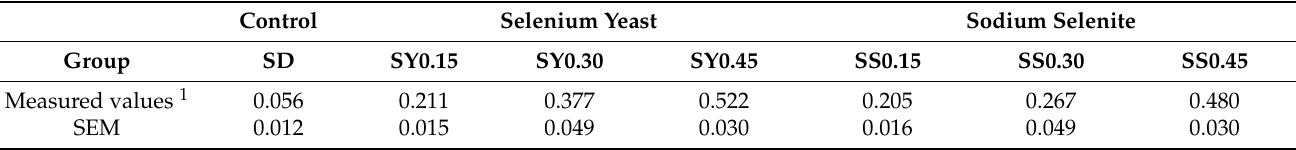
Table 2. Dietary selenium